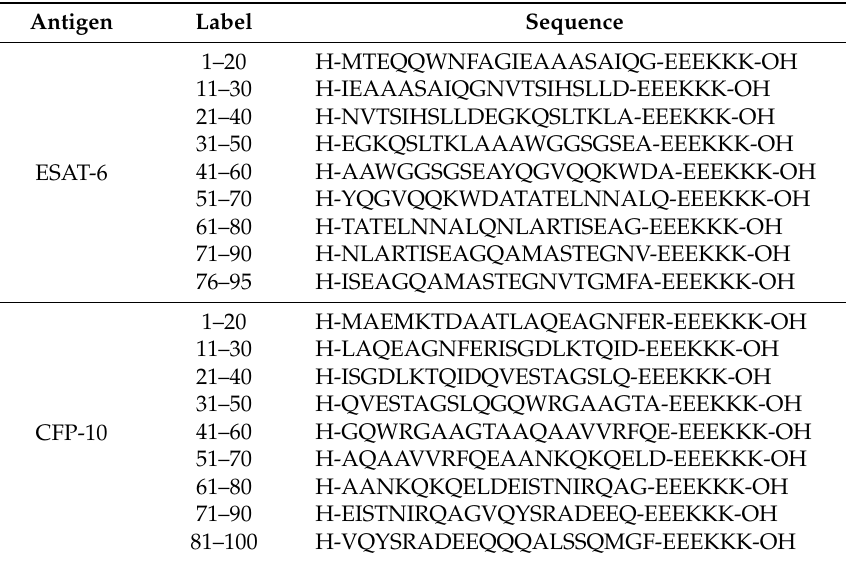
Table 2. Sequence of the peptide